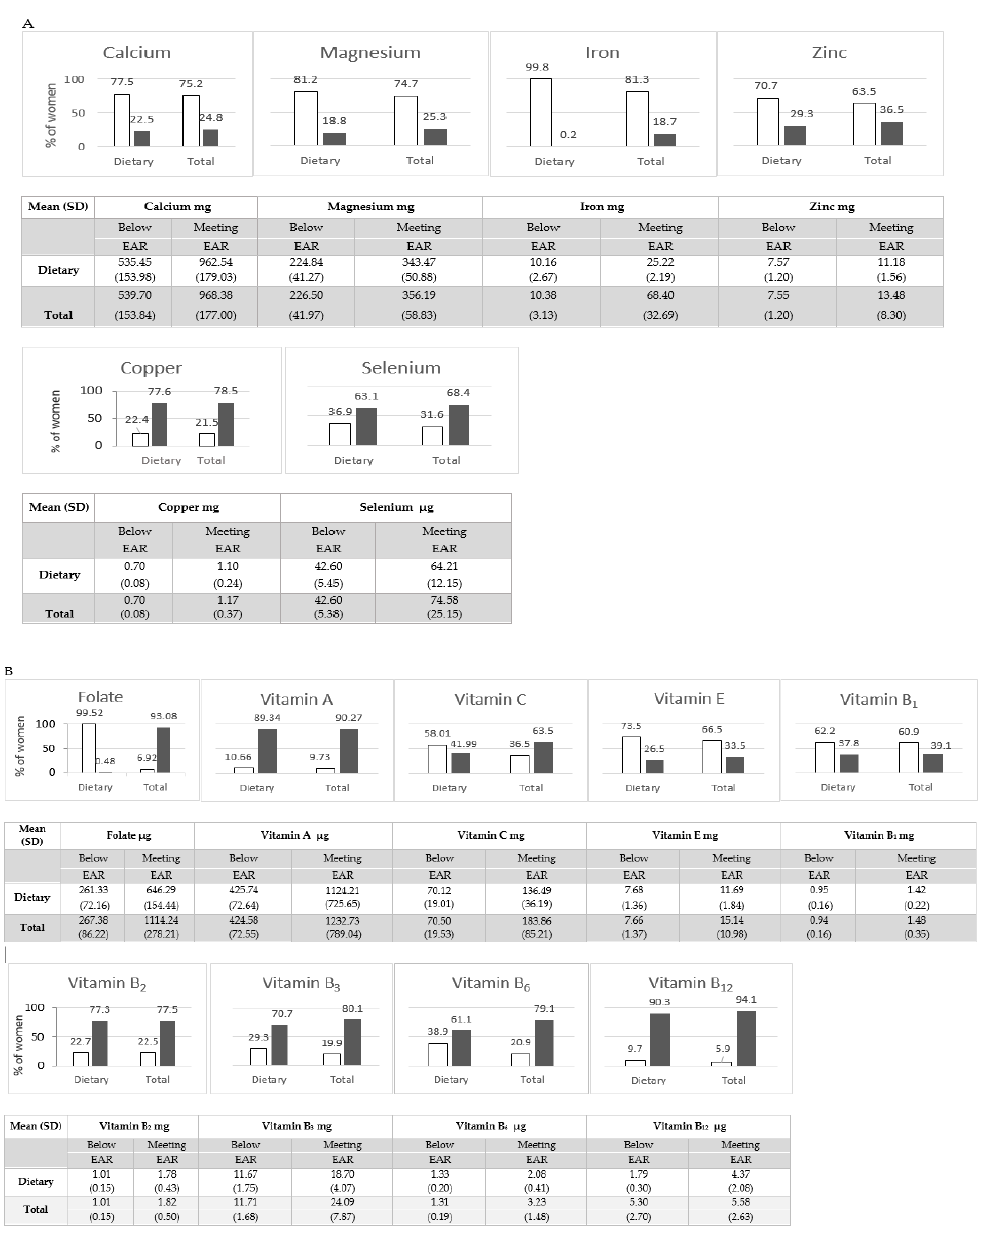
Figure 1. Intake of essential elements ( A ) and vitamins ( B ) from diet and total intake (from diet and supplementation) according to daily intake category: (cid:3) Below EAR, (cid:4) Meeting EAR. Note: EAR (Estimated Average Requirement) for essential elements and vitamins during pregnancy are presented in Supplementary Materials (Table